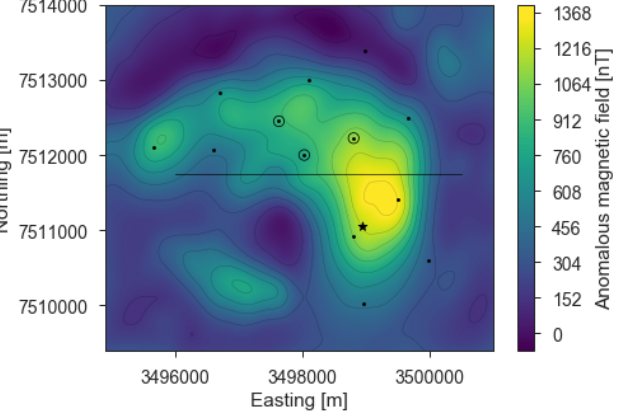
Figure 5. Processed magnetic data showing the anomalous magnetic field intensity, with the cross- section location (line) at which we evaluate our results; the locations where we evaluate the magnetic likelihood functions (filled dots); and the geological likelihood (star). We use the locations with an extra circle to invert for the susceptibility of the